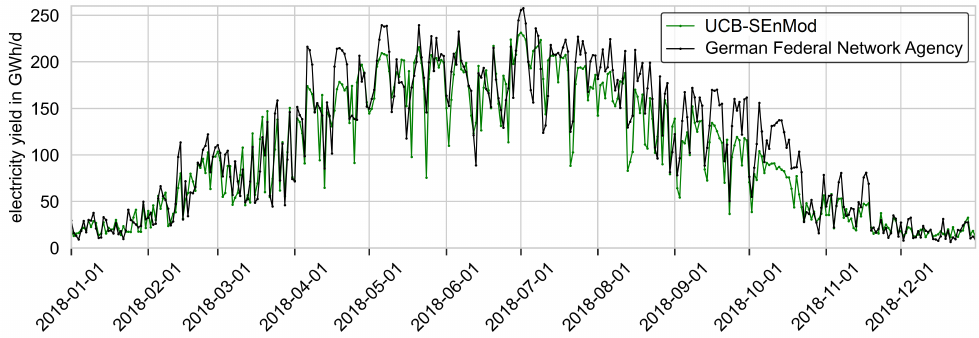
Figure 3. Validation of the photovoltaic yield simulations using Germany’s example in 2018 with the German Federal Network Agency data. The datasets are aggregated to daily totals. Data is trend adjusted to compensate plant capacity’s growth during the year without changing the average. The example’s validation shows that our model simulation produces good results even under simplified assumptions. However, by simulating several plants located in regions that differ climatically, the RMSE can be